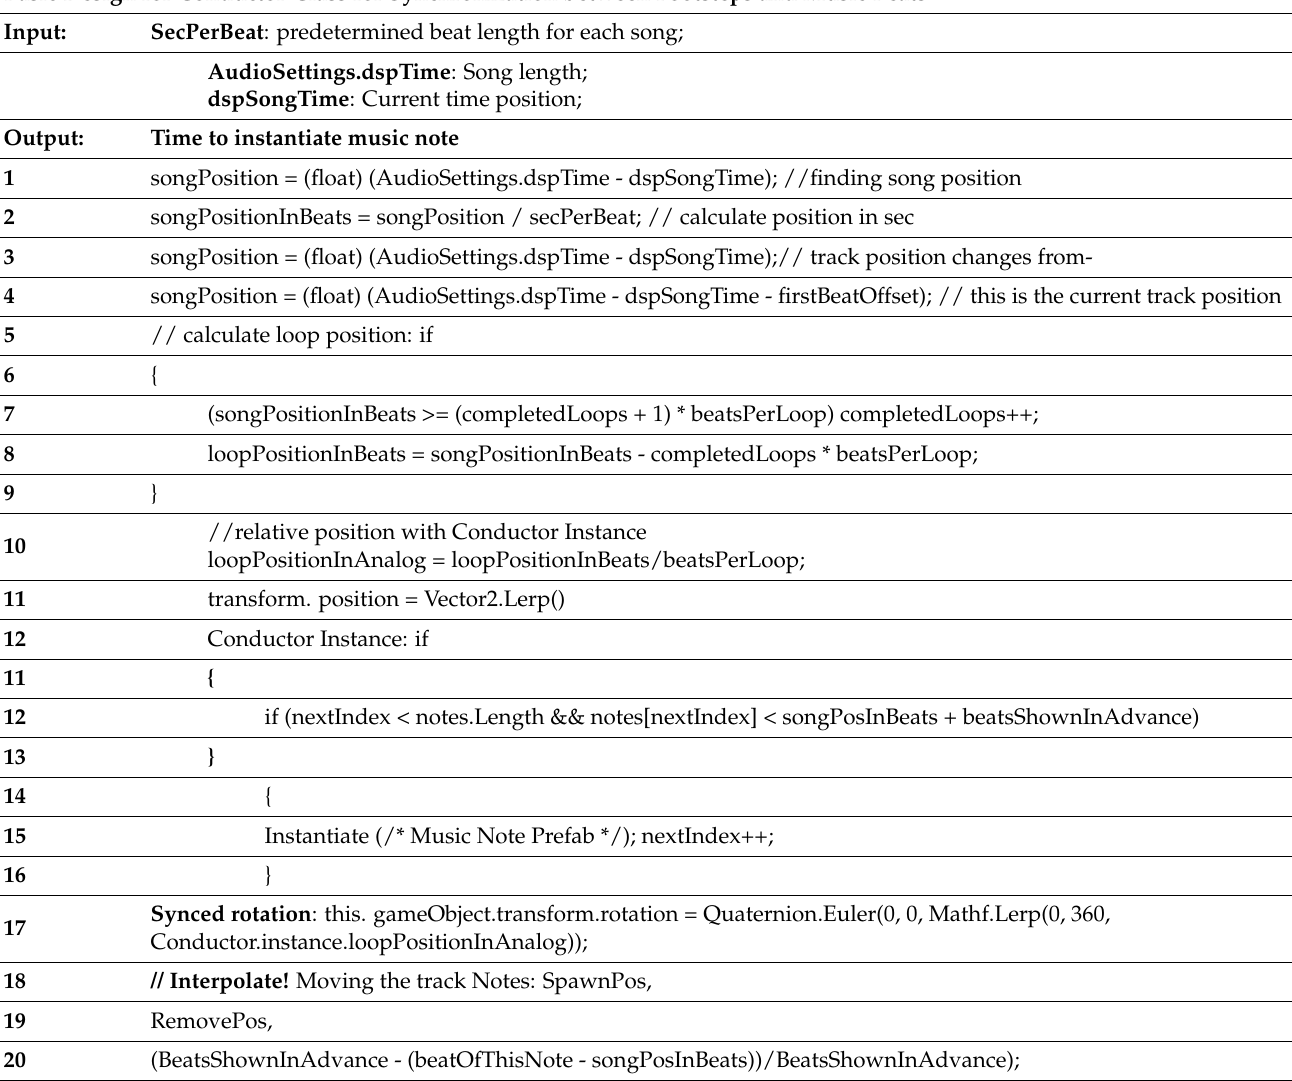
Table 1. C sharp language Algorithm program design: Basic parameter of the Conductor class is used to synchronize footsteps with